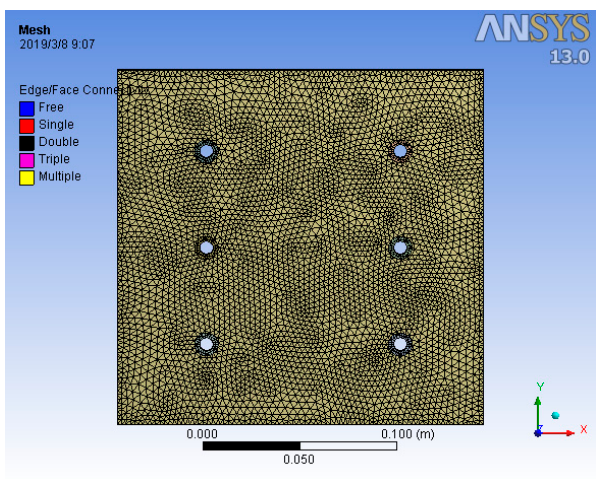
Figure 4. Grid diagram of the three-dimensional model of the FEM.